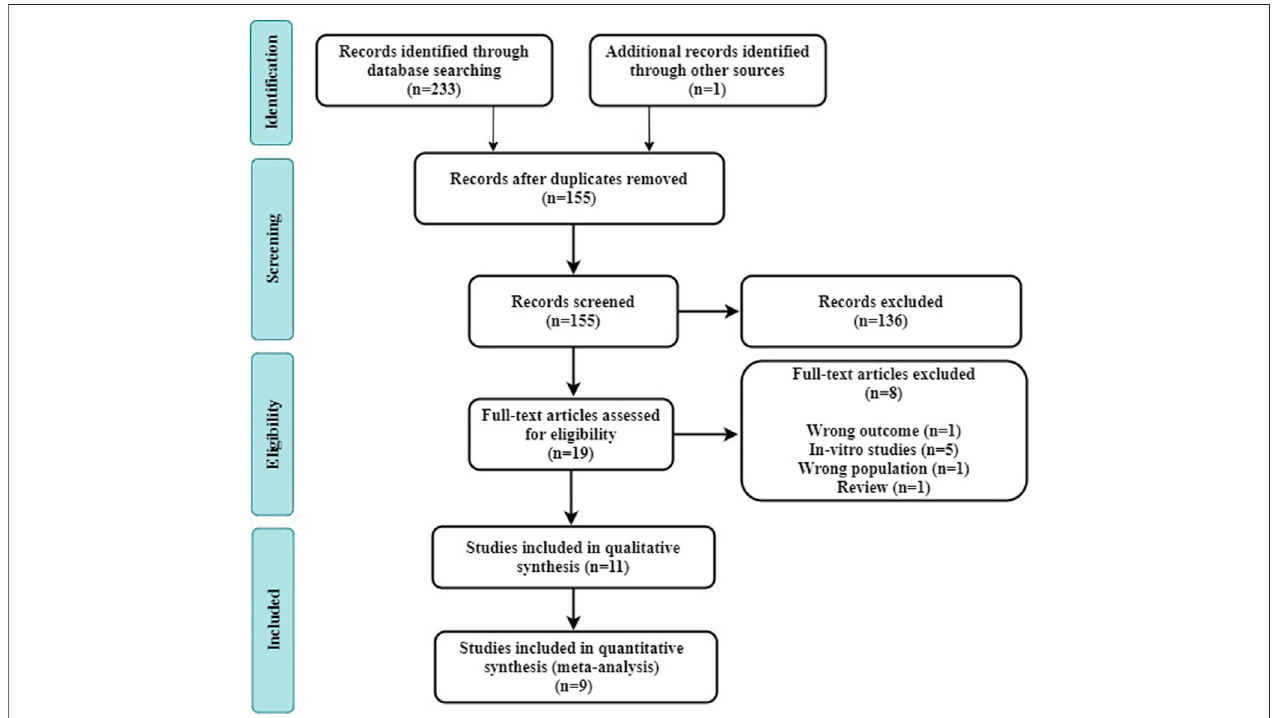
FIGURE 1 | Flow diagram of the systematic review and literature search results of the